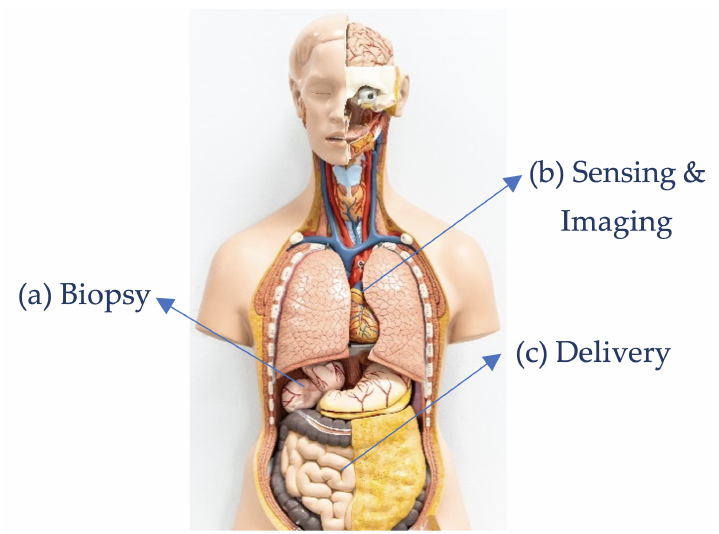
Figure 6. Different medical procedures performed by nanorobots: ( a ) Nanorobots for biopsy, ( b ) Nanorobots for sensing and imaging of cells and tissues inside the human body, ( c ) Nanorobots for the delivery of drugs to targeted